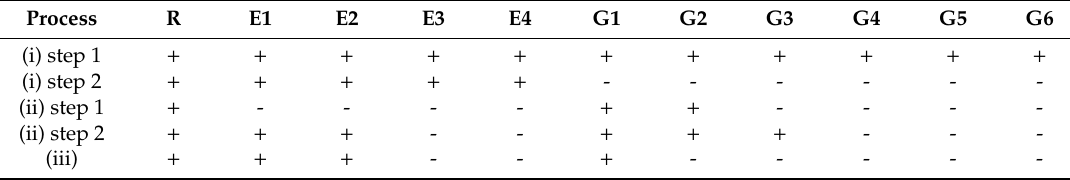
Table 4. MALDI MS analysis of product mixtures from two-enzyme